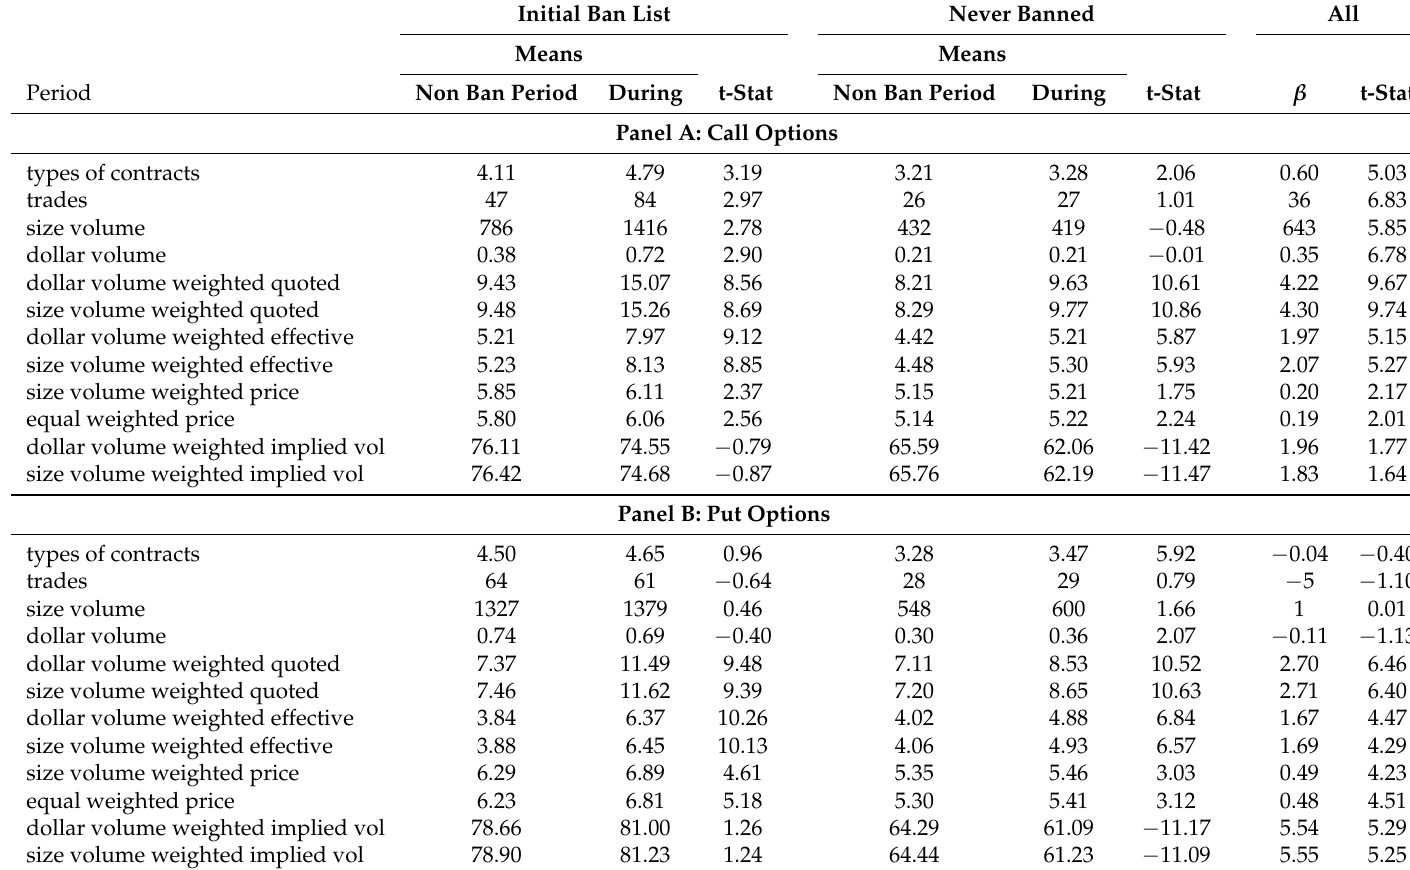
Table 5. Cross sectional means and t-statistics for option trade summary statistics: In the money